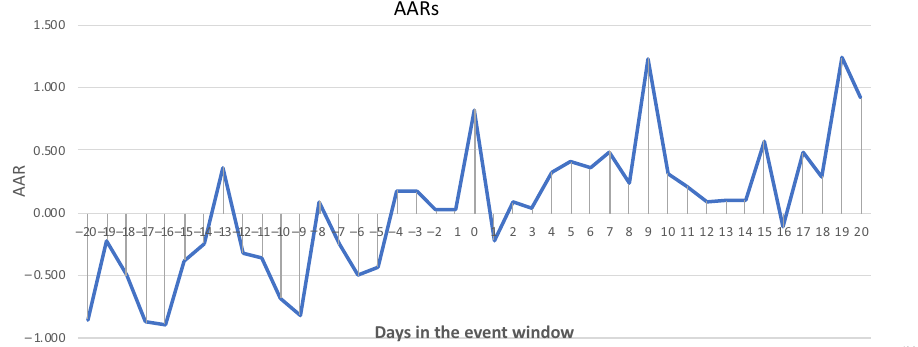
Figure 2. Market reaction to BUY recommendations of